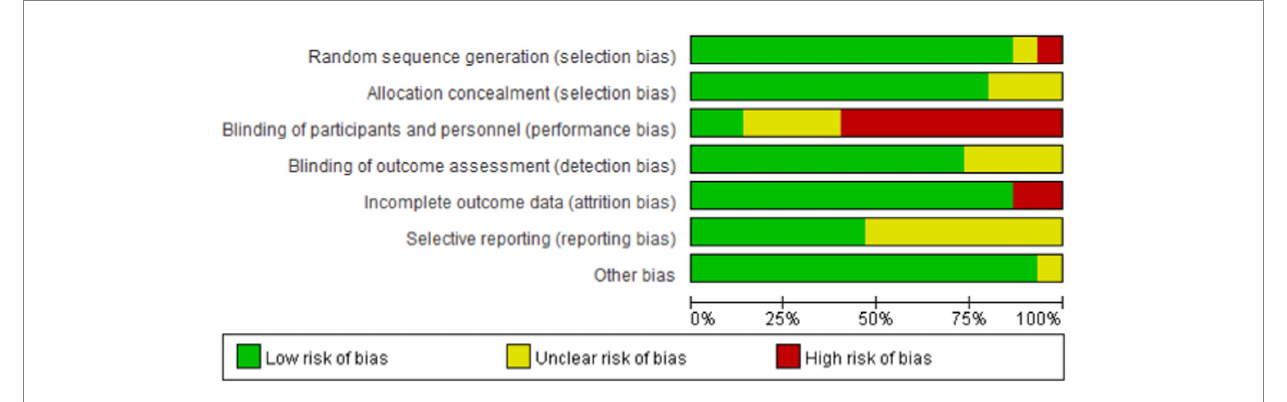
FIGURE 3 Risk-of-bias